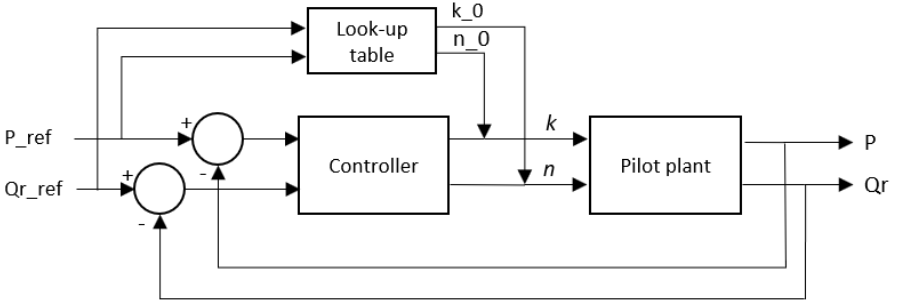
Figure 4. Diagram of the fuzzy controller.